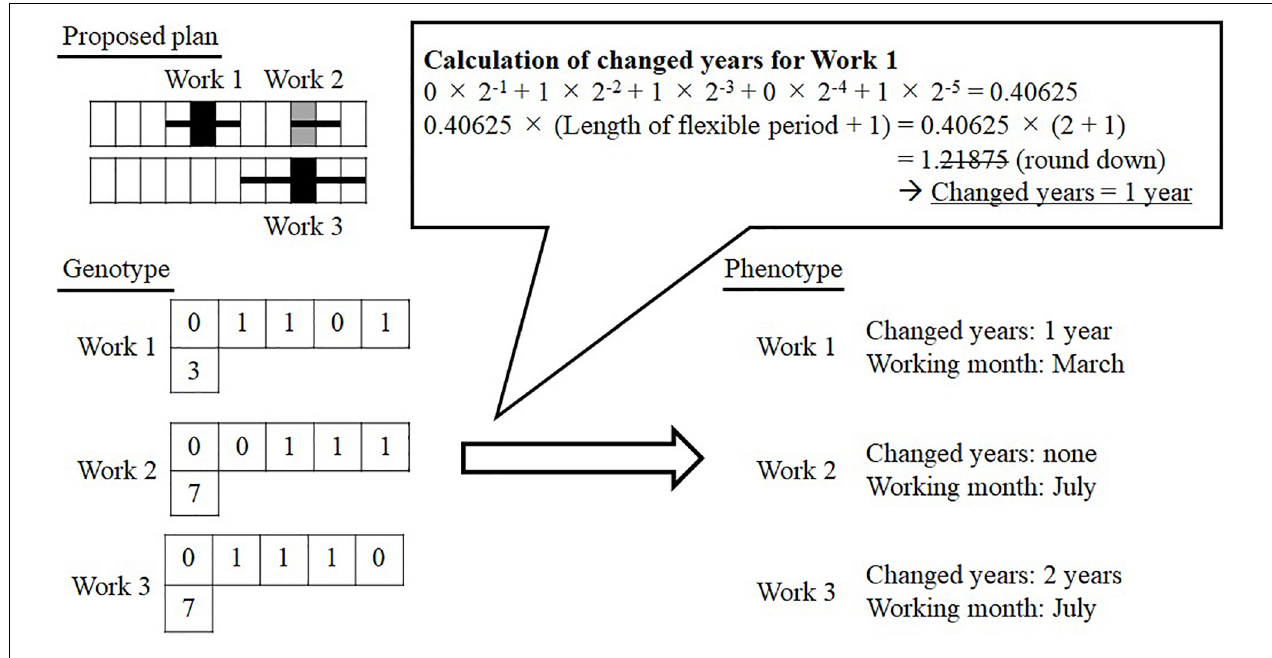
FIGURE 8 | Coding rule for flexible periods.